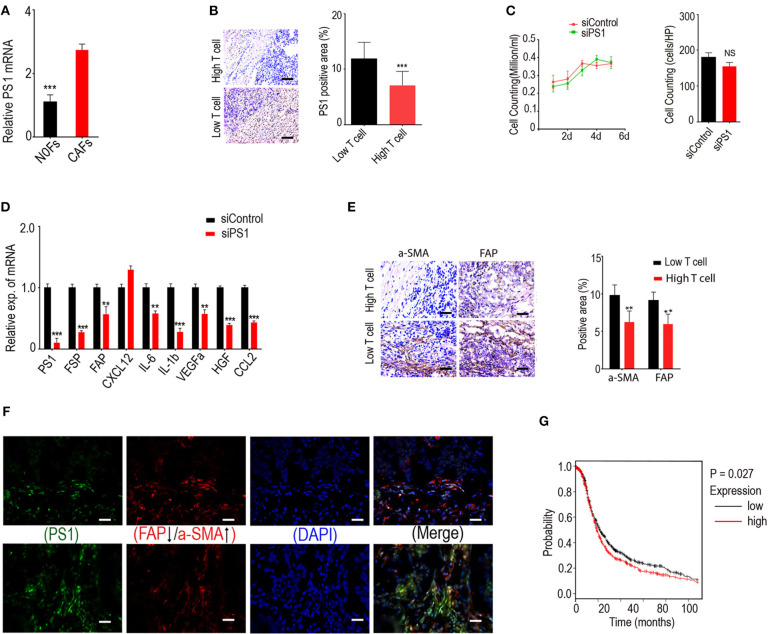
Low tumor-infiltrating lymphocyte counts in ovarian tumor coincide with activated CAFs due to highly expressed presenilin 1 (PS1). (A) Expression of PS1 in CAFs and NOFs by quantitative PCR (qPCR). CAFs, cancer-associated fibroblasts; NOFs, normal ovarian fibroblasts (n = 5). ***p < 0.001. (B) Expression of PS1 is strongly correlated with tumor-infiltrating T lymphocytes. Results were means SD of triplicate samples from three representative experiments. Scale bar = 50 μm. ***p < 0.001. (C) Cell growth after patient-derived cancer-associated fibroblasts silenced by small interfering RNA (siRNA). Results obtained after 6 days culture (n = 3). (D) Expression of PS1, fibroblast-specific protein (FSP), fibroblast activation protein (FAP), and several immunosuppressive factors checked by qPCR after silencing PS1 in patient-derived fibroblasts. **p < 0.01, ***p < 0.001. (E) CD8+ cytotoxic T lymphocyte (CTL) density in human ovarian tumor samples checked by immunohistochemistry and its association with the expression of two CAF markers alpha smooth muscle actin (α-SMA) and FAP. Scale bar = 50 μm. **p < 0.01. (F) PS1 colocalized with different CAF markers in human ovarian tumors. Scale bar = 50 μm. (G) Kaplan–Meier plot shows PS1 is correlated with poor prognosis in ovarian cancer patients. Error bars denote mean ± SEM (standard error of the mean). *p < 0.05; **p < 0.01; ***p < 0.005; ns, statistically not significant. Statistical analyses were performed using one-way ANOVA with Tukey multiple comparison test.